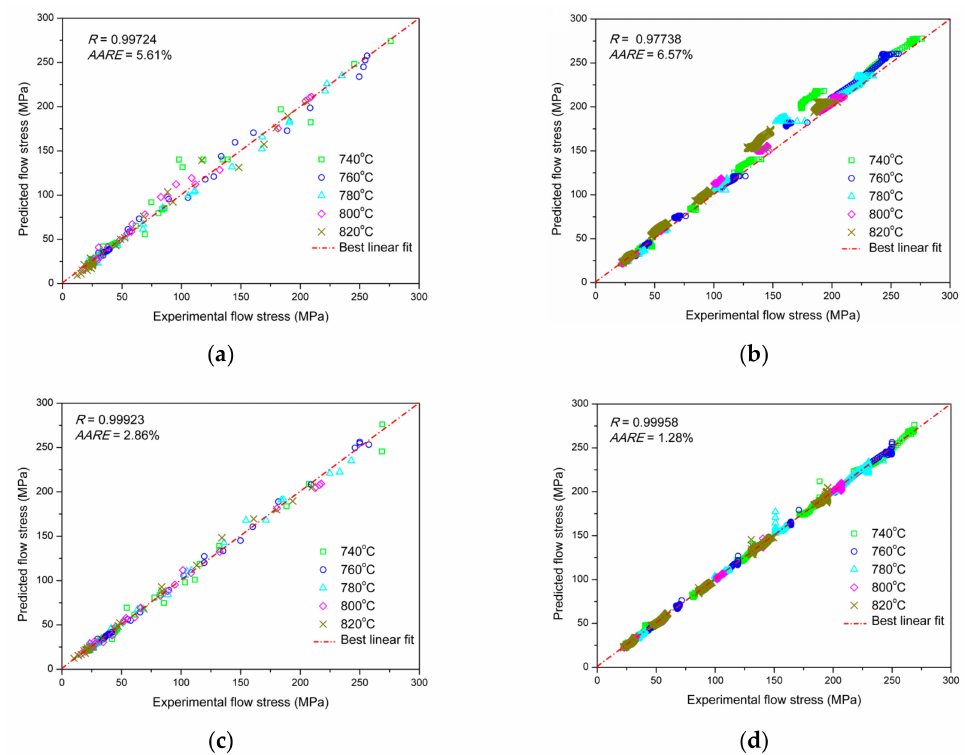
Figure 11. Correlations between the experimental flow stress and the predicted flow stress obtained from the OC model ( a ) and ( b ); MC model ( c ) and ( d ). Here, (a) and (c) represent the flow stress under the prior-peak stage; (b) and (d) denote that of the post-peak stage.